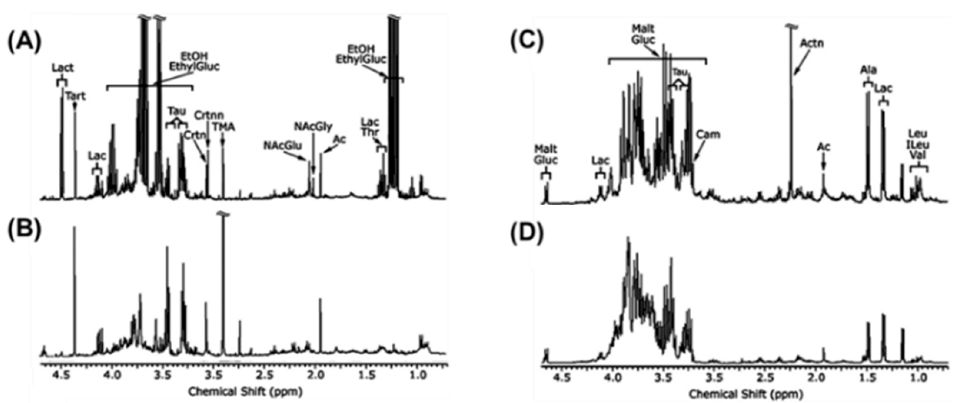
Figure 4. 1 H NMR spectrum of ( A ) mice urine with alcohol treatment; ( B ) mice urine with control; ( C ) mice liver with alcohol treatment; ( D ) mice liver with control. Solution state NMR experiments